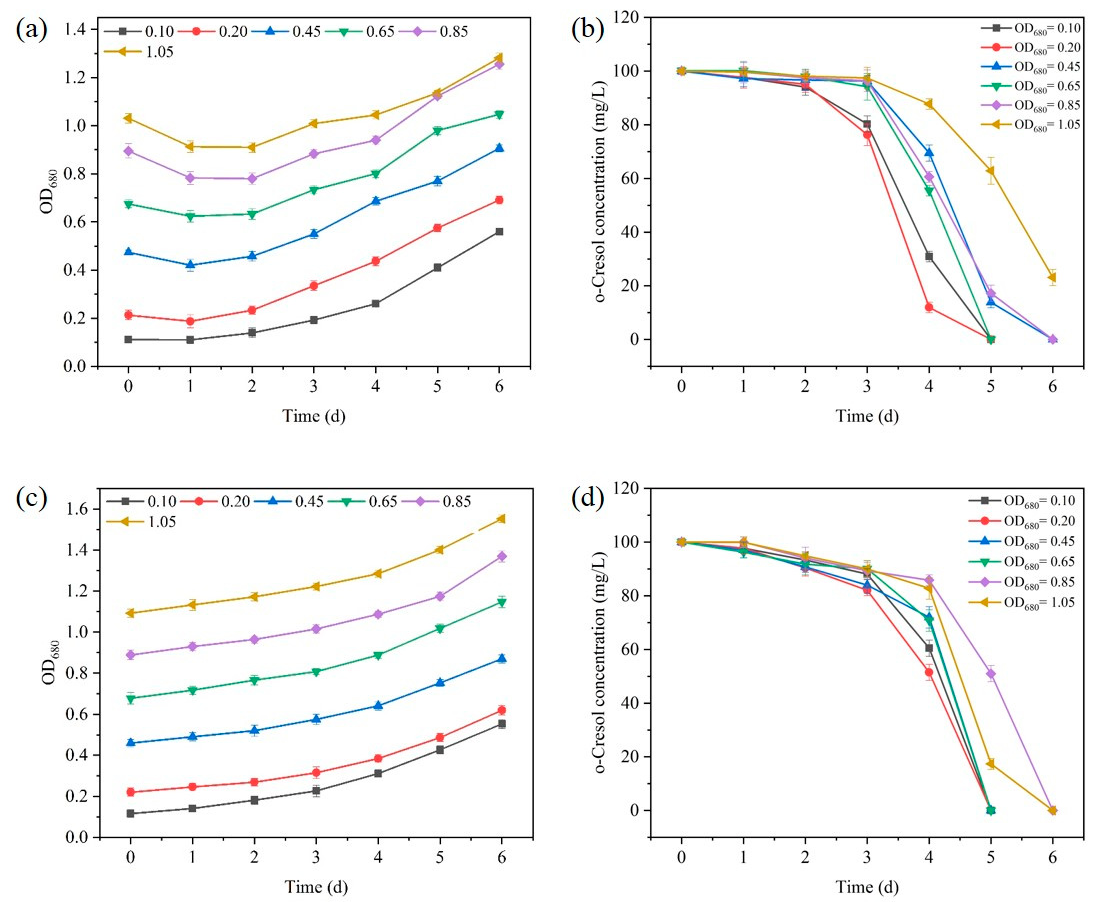
Figure 3. Growth of Selenastrum capricornutum and the degradation of o-cesol under different microalgae densities. ( a ) Growth curve of Selenastrum capricornutum at pH of 6.0; ( b ) degradation curve of o-cresol at pH 6.0; ( c ) growth curve of Selenastrum capricornutum at pH 7.0; ( d ) degradation curve of o-cresol at pH 7.0.